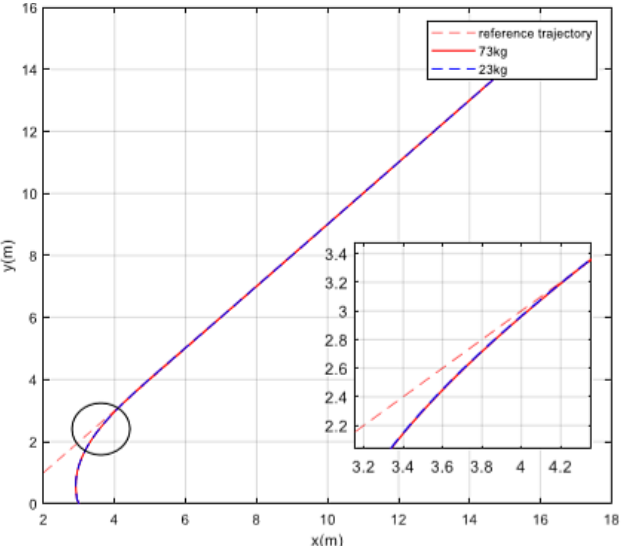
Figure 7. Result of tracking linear trajectory under varying loads.